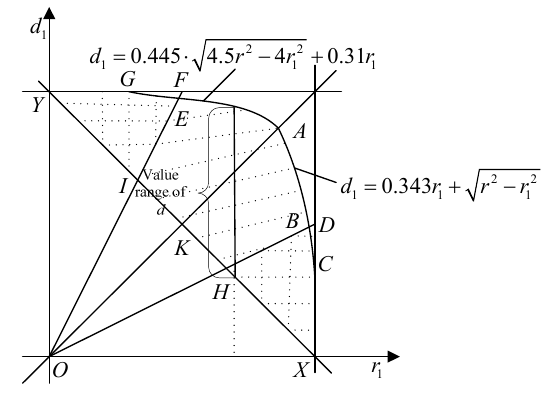
Figure 14. The feasible region in Heterogeneous networks. The coordinates of the points in Figure 14 are shown in Table 2.